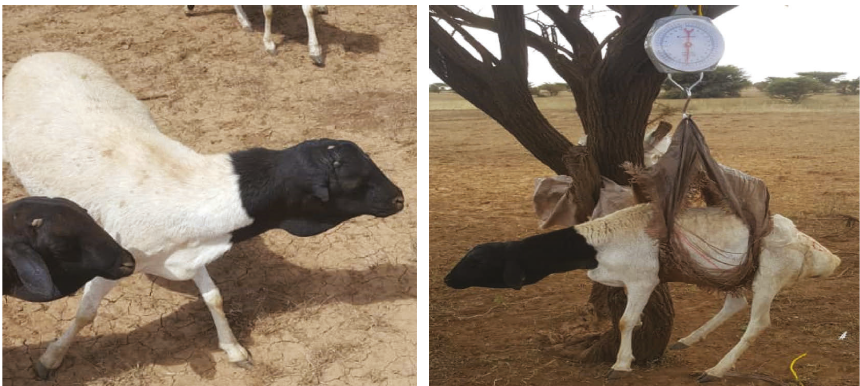
Figure 2: Straight head profile, well-developed dewlap, and absence of horn in Blackhead Somali